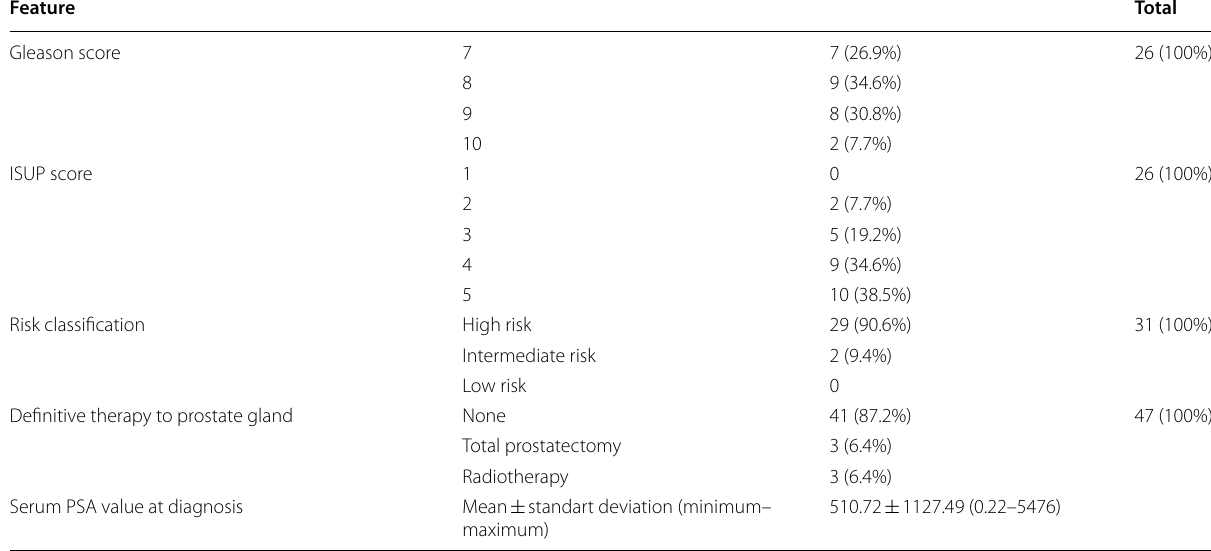
Table 1 Clinical and pathological features of patient group Feature